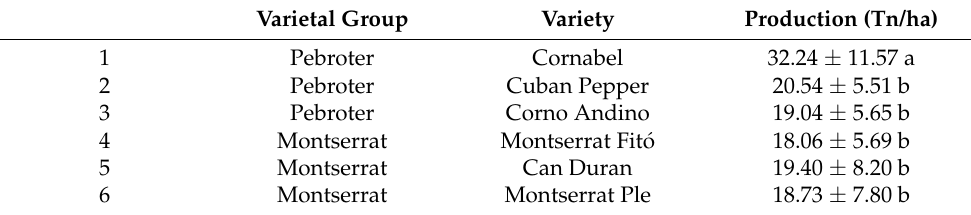
Table 4. Productivity of tomato varieties from the organic fertilization